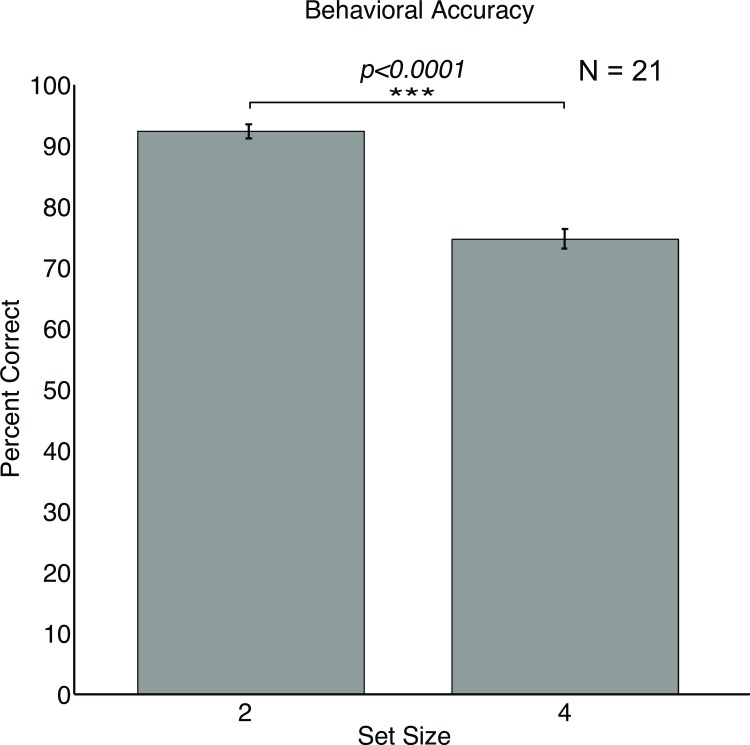
Behavioral accuracy for the set size 2 and set size 4 conditions.Participants performed significantly better on set size 2 condition. Error bars represent standard errors of the means.